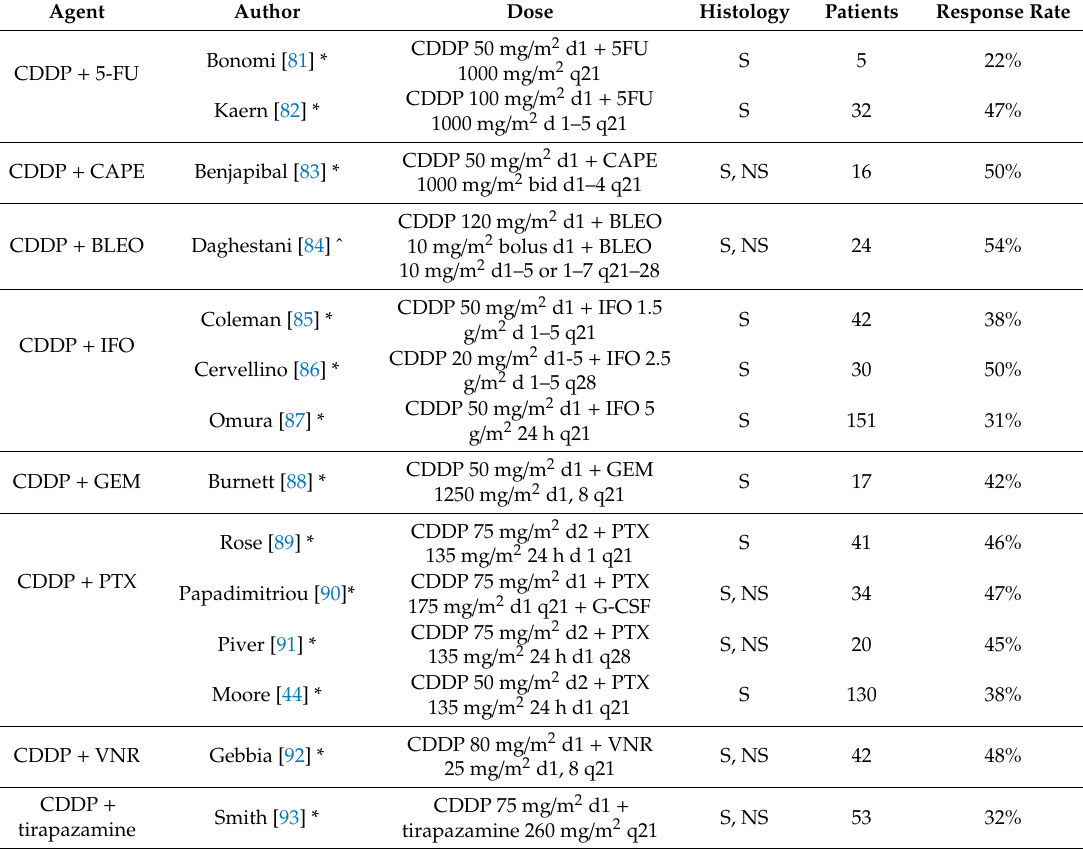
Table 2. Phase II trials of cisplatin-based doublets in metastatic, persistent, or recurrent carcinoma of the uterine